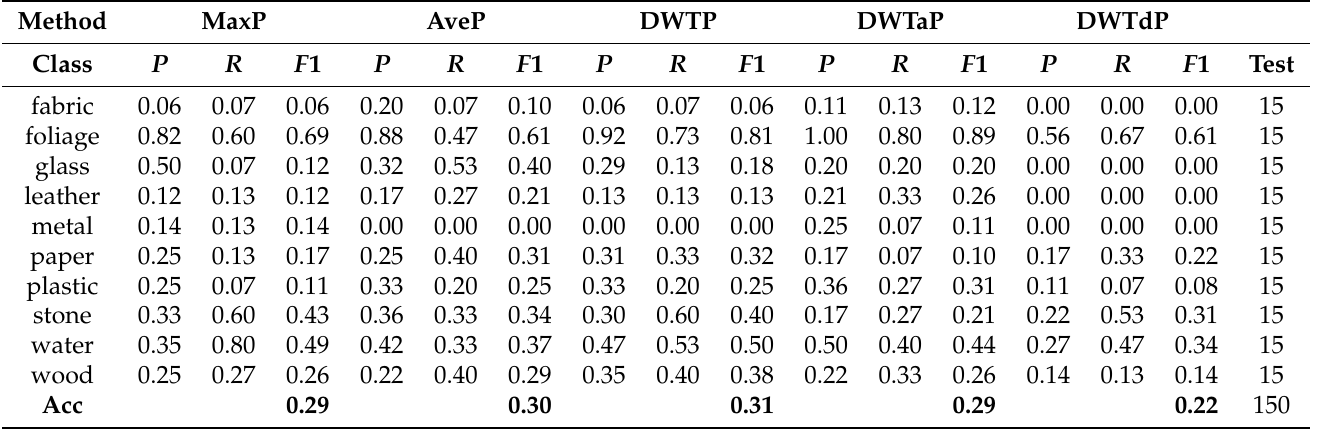
Table A5. Experiment 2 with Adam Optimizer—classification report for the FMD